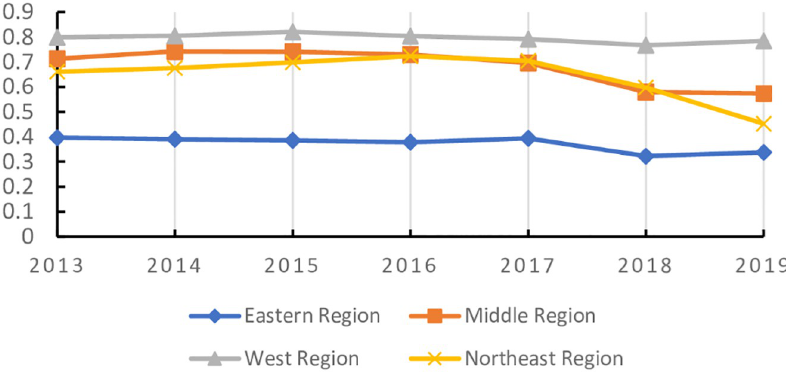
Fig 5. Chart of changes in the level of digital economy in China’s four economic regions from 2013 to 2019.